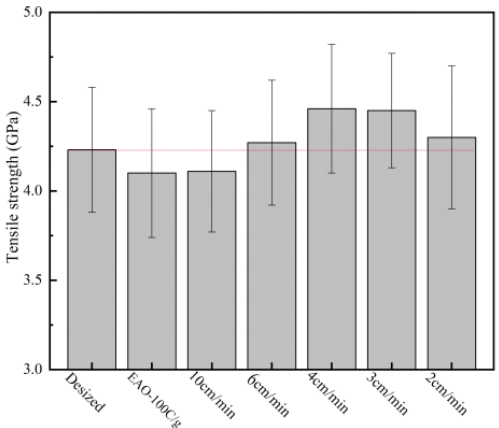
Figure 6. Single-filament tensile strength test of CNTs/CF multiscale reinforcements prepared at different moving speeds. The flow rate of H 2 and C 2 H 2 was 0.3 L/min.